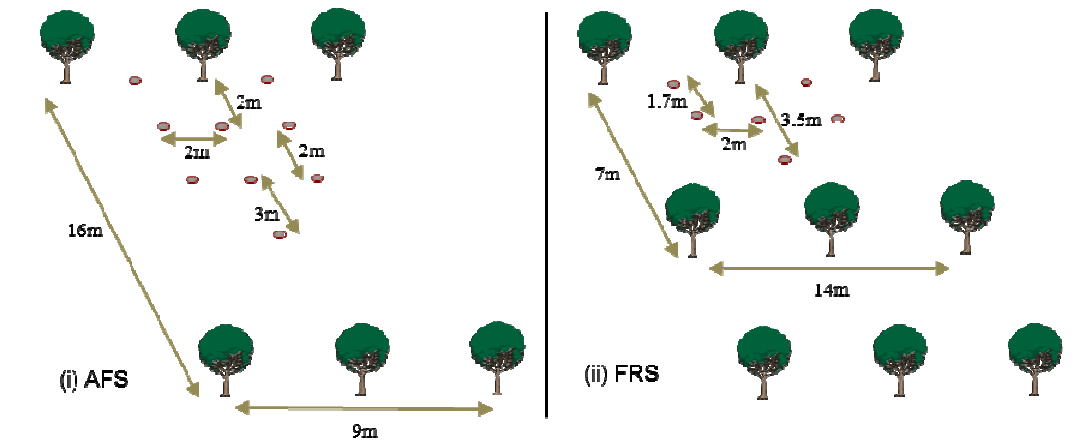
Fig. 2. Soil coring spots (brown ellipse between tree rows and close to the tree to be harvested) in (i) AFS and (ii) FRS of Populus euramaricana I-214. Distance in the drawing is not to the scale. Tree line, north-south, is the X axis and Alley is the Y